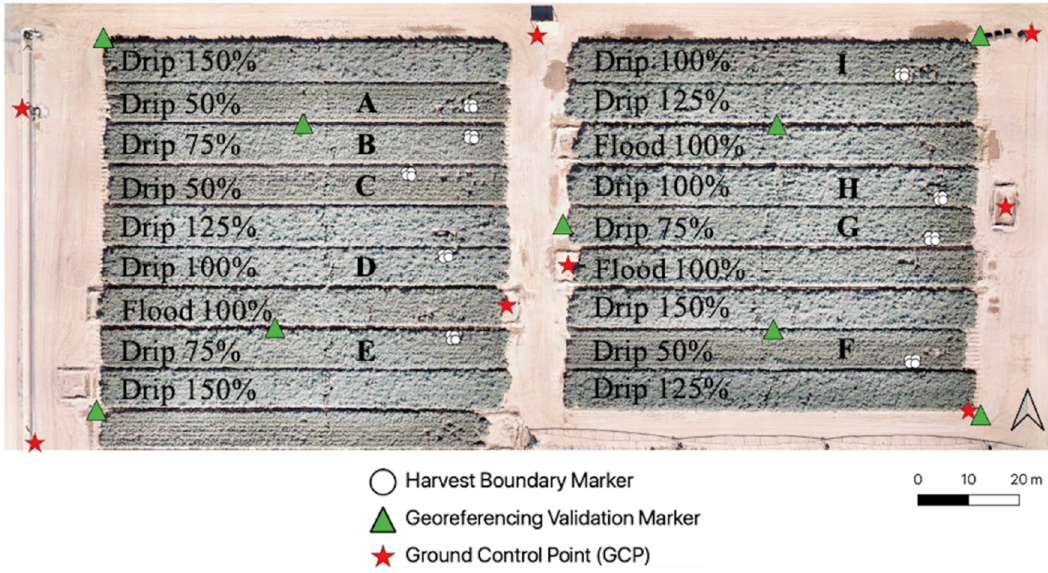
Figure 1. An RGB orthomosaic (19 December 2019) of the ROI depicting variable irrigation modalities and application rates. Treatments A–I (Drip 50%, Drip 75%, and Drip 100%) were examined in the research presented here. All above-ground plant material occurring within one-square-meter samples was removed for analysis.